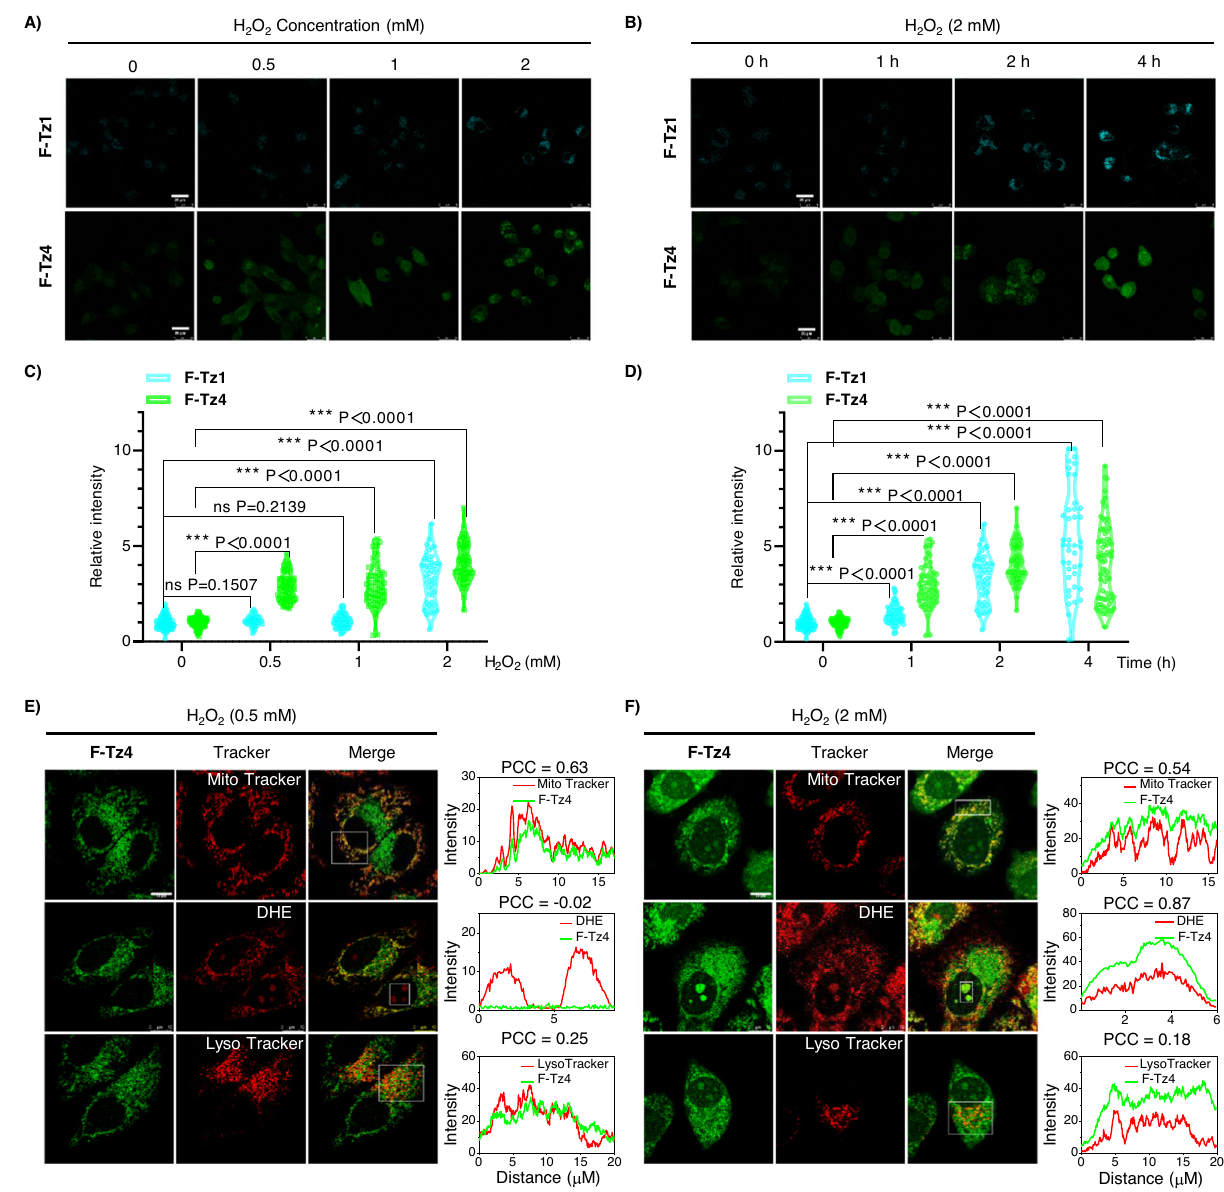
Fig.3|MultiplexedimagingofcellularsuperoxidelevelswithprobesF-Tz1and F-Tz4. A , B Fluorescence images of HepG2 cells stained with either F-Tz1 or F-Tz4 (each5 μ M,30min).CellswerepretreatedwithvariousdosesofH 2 O 2 for2h( A )or 2mM H 2 O 2 for various time ( B ). Scale bar: 25 μ m. C , D The statistically quanti fi ed dataonthecellular fl uorescenceintensityin( A )and( B ).Thedatawerenormalized to thecontrolgroup,and P valueswereanalyzedbytwo-tailed unpaired t-test,95% Con fi dence interval. F-Tz1 : n =97 cells for 0mM H 2 O 2 0h, n =45 cells for 0.5mM H 2 O 2 2h, n =66 cells for 1mM H 2 O 2 2h, n =49 cells for 2mM H 2 O 2 2h, n =56 cells for2mMH 2 O 2 1h, n =41cellsfor2mMH 2 O 2 4h; F-Tz4 : n =116cellsfor0mMH 2 O 2